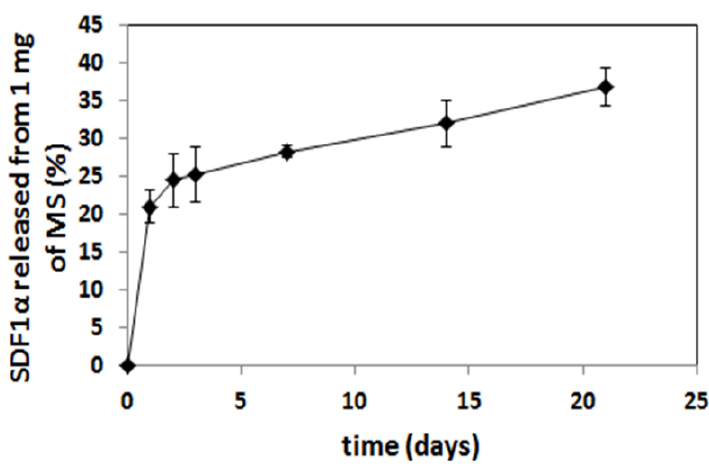
Figure 7. Cumulative in vitro release profile of SDF-1 α from PLA/GA/TMC MS.